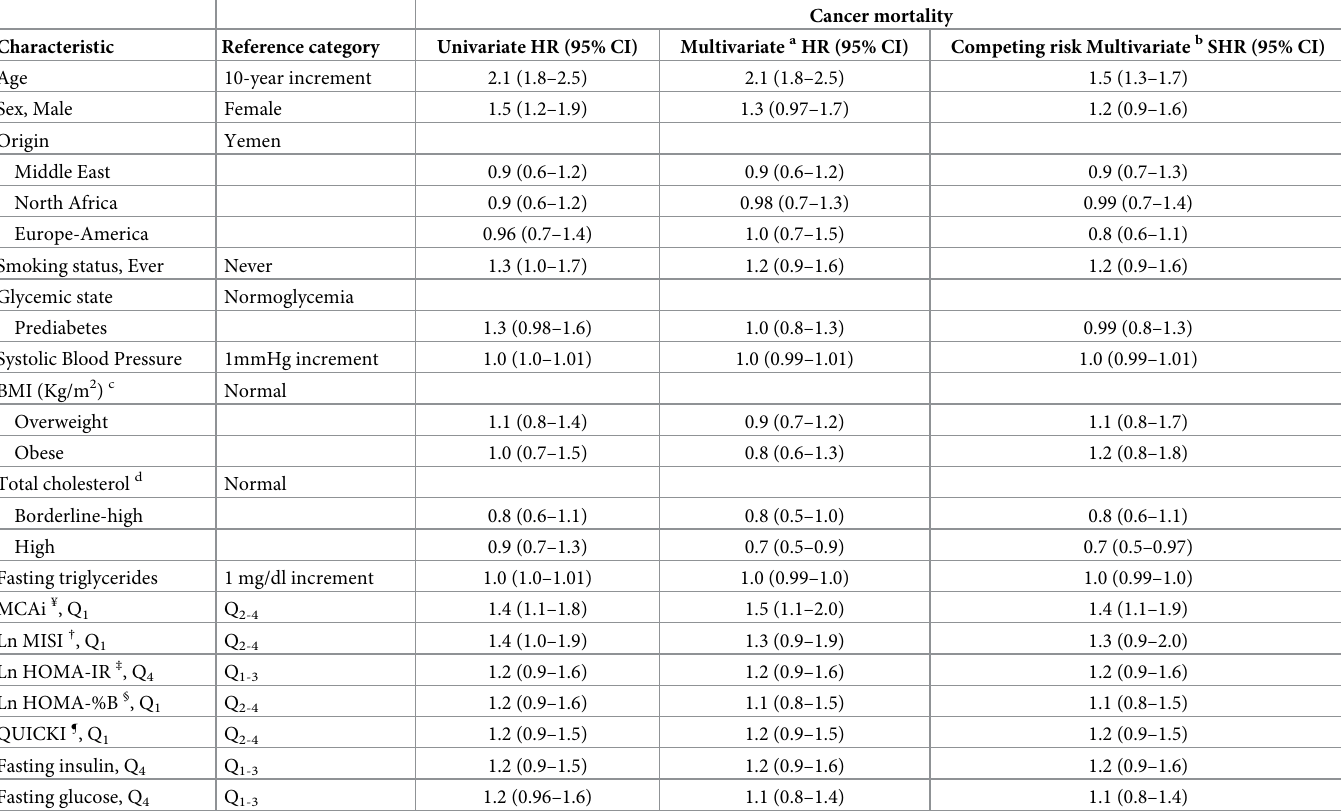
Table 2. Cox regression models for associations between baseline characteristics of 1,610 men and women free of diabetes at baseline and cancer mortality over a mean follow-up of 36.7